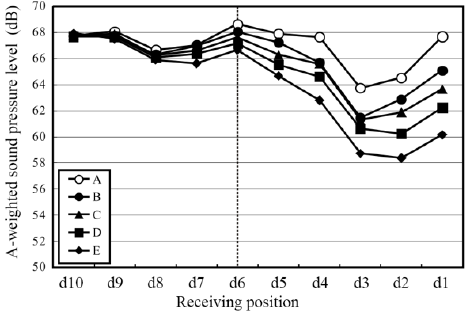
Figure 16. Results of the A-weighted sound pressure level on line “d” on each absorption pattern. The dotted line represents the boundary of the front room and evaluation space.